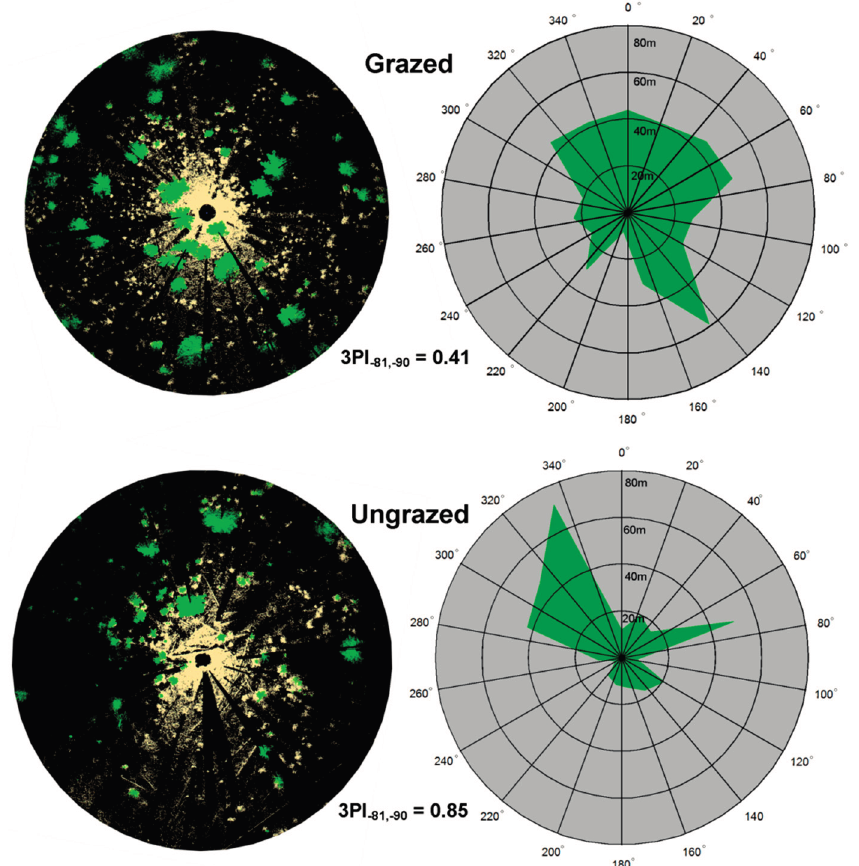
Figure 5. Visual representations of TLS data in a thinned and burned and grazed plot ( above ) and a thinned and burned and ungrazed plot ( below ). On the left are overhead views of raw TLS points rendered in Cartesian coordinates. The scan location is at the center, points greater than scanner height (2 m) are shown in green, and points less than scanner height are shown in beige, black areas had no points collected. The radius of each extent is 80 m. On the right are polar plots showing the median r for 18 different azimuthal angles ranges. The three-dimensional Vegetation Patchiness Index (3PI) is calculated for each plot using zenith angles from − 81° to − 90°. Mean and standard deviation used to calculate 3PI are: grazed (4.1, 1.7), ungrazed (23.4, 19.9).